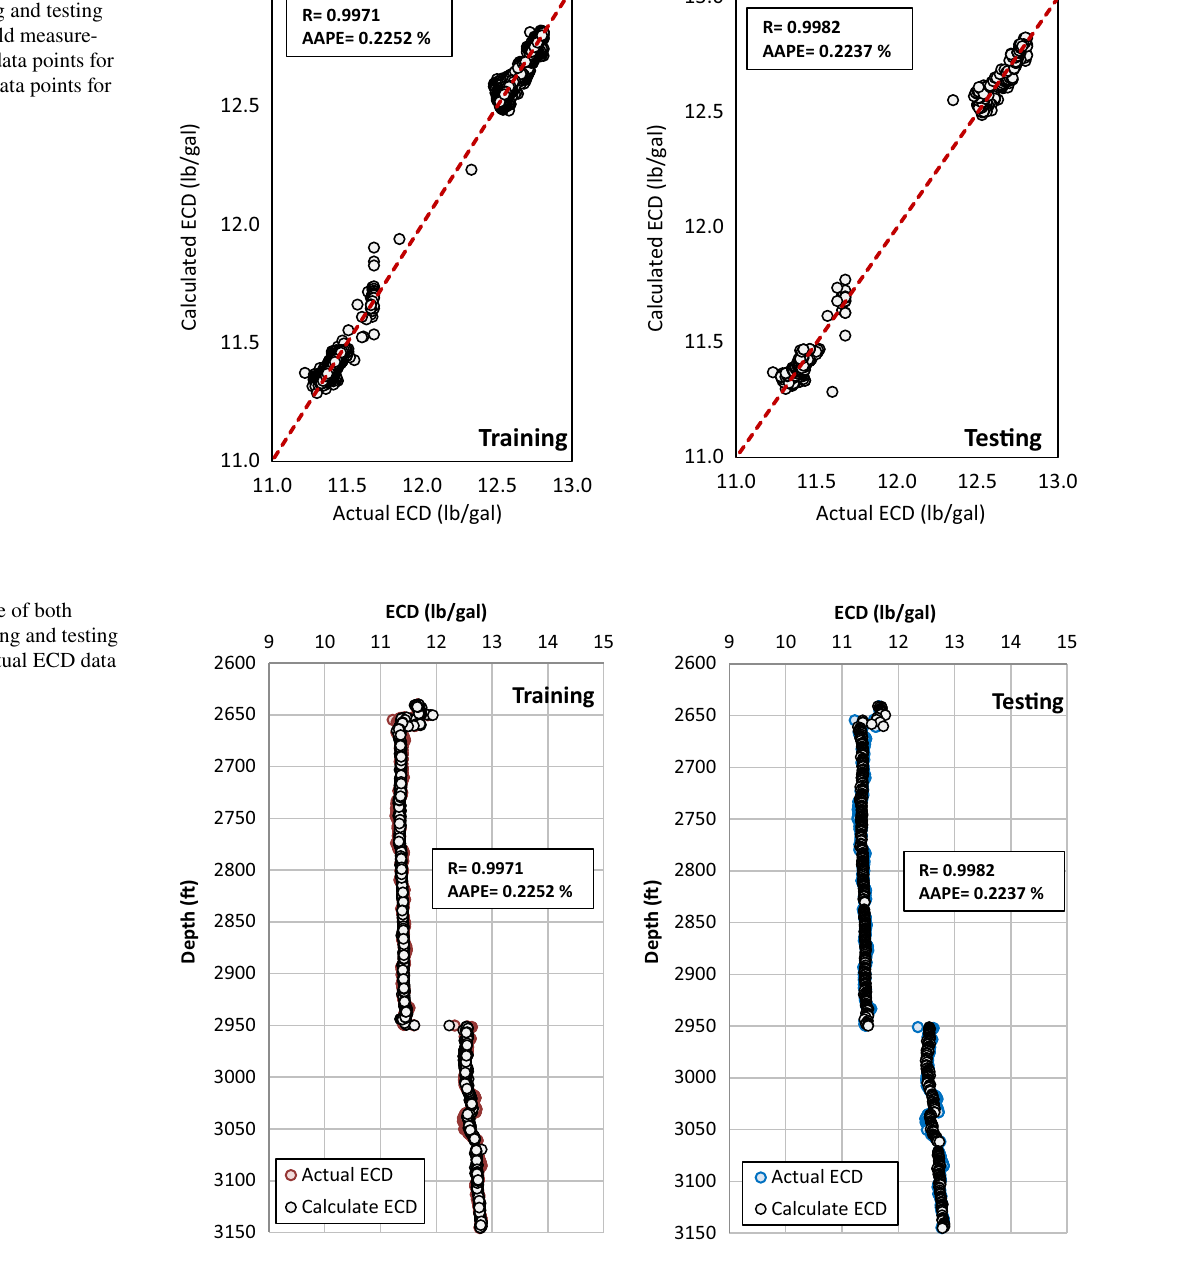
Fig. 6 Predicted ECD for both ANN training and testing compared with field measure- ment using 1664 data points for training and 712 data points for testing